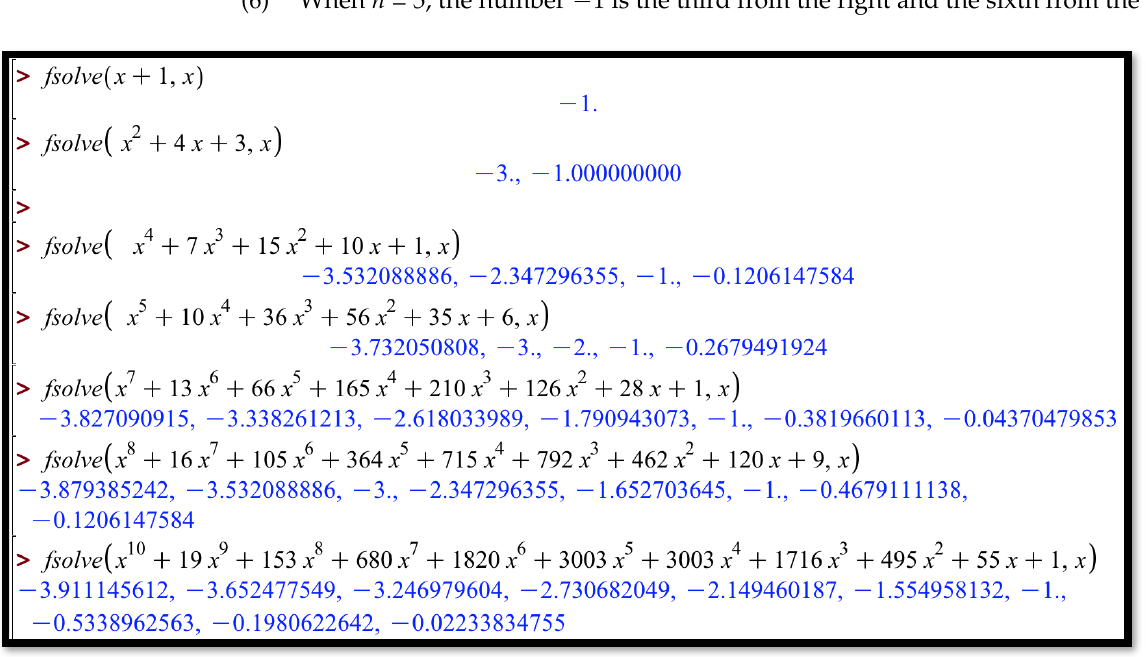
Figure 9. Exploring OAs among the roots of 𝑃 3𝑛+1 (𝑥) for x = − 1.